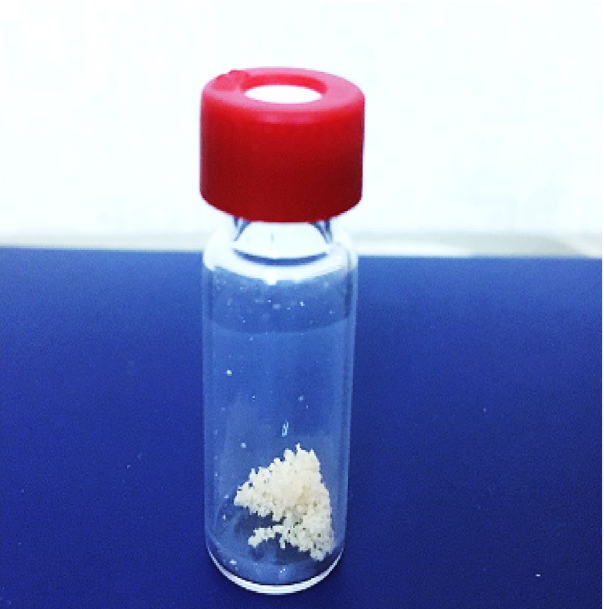
Figure 7. cPNIPAAM produced in homogenous phase of SC-CO 2 solvent and DMF co-solvent after